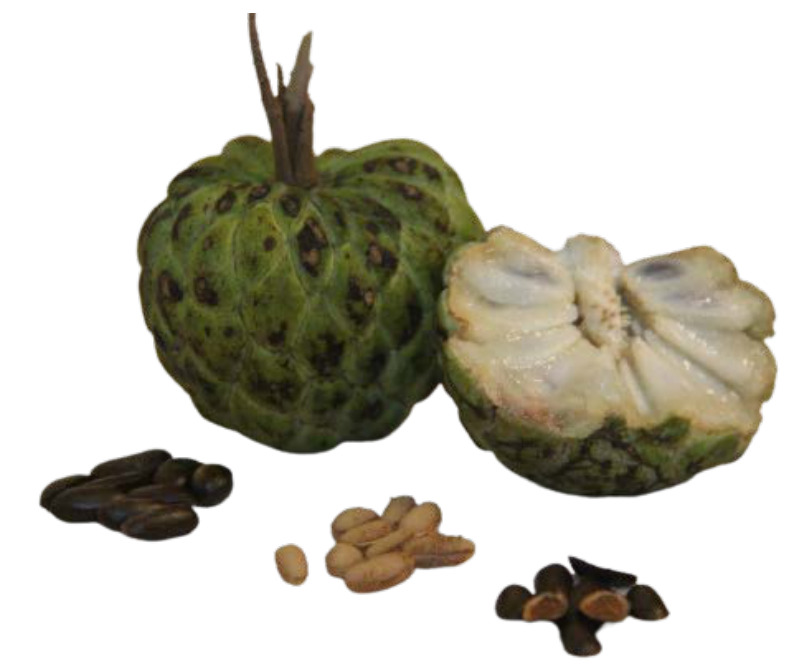
Figure 1. Custard apple fruit and its seed by-products.